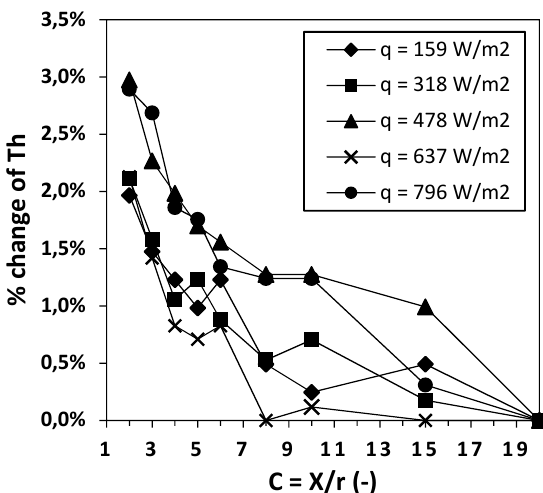
Fig. 9. Percentage change of temperature with distance from wall to centre of the cylinder